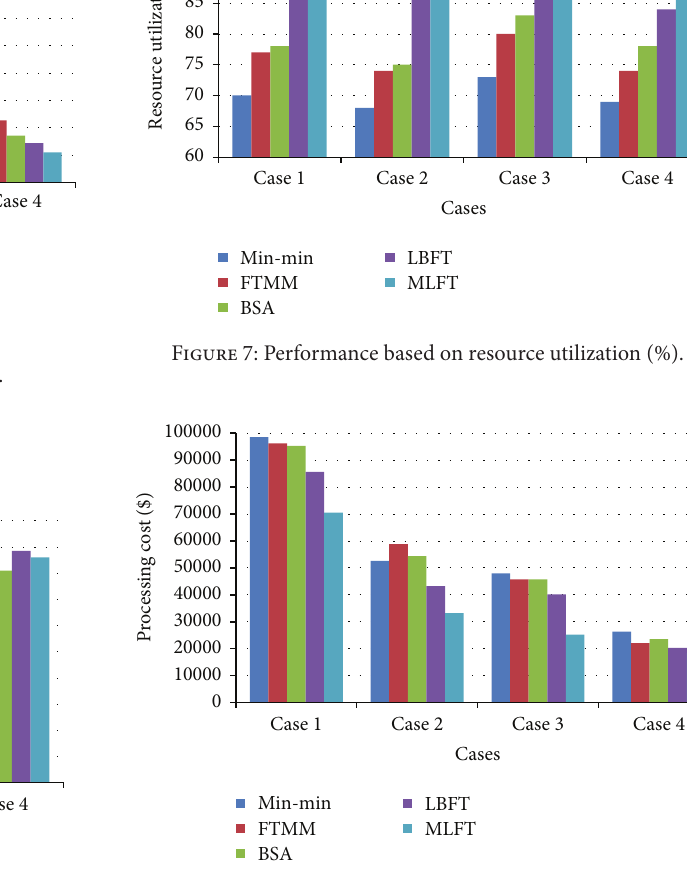
Figure 8: Performance based on processing